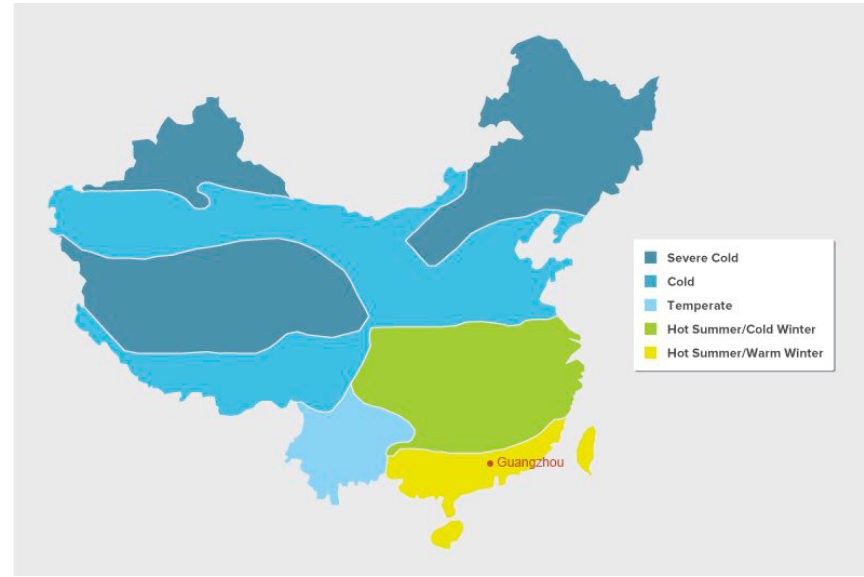
Figure 3. Location of the test city among the thermal engineering design zones of China.